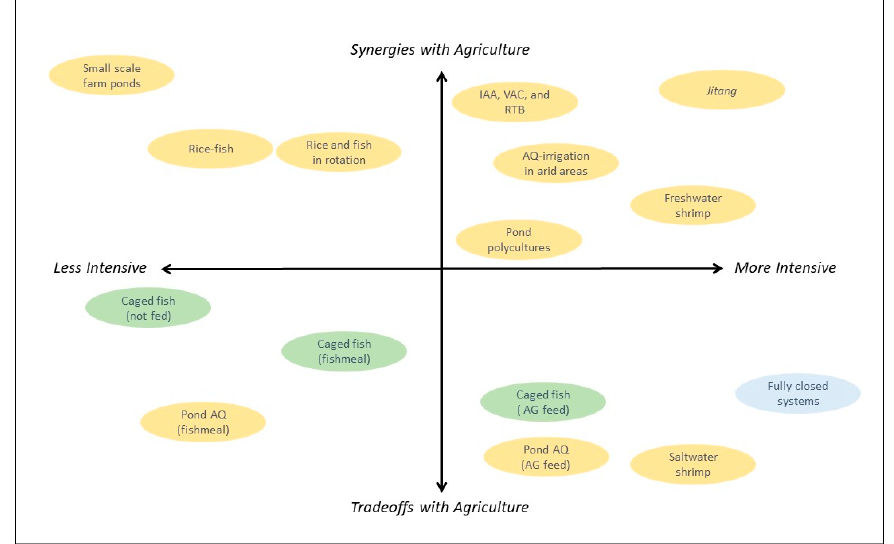
Figure 4. Quadrant analysis of synergies and tradeoffs between agriculture and various forms of aquaculture (y-axis) verses intensiveness of the aquaculture practices (x-axis). Aquaculture categories are color-coded as open (green), partially closed (orange), and closed (blue). Abbreviations are: AG,